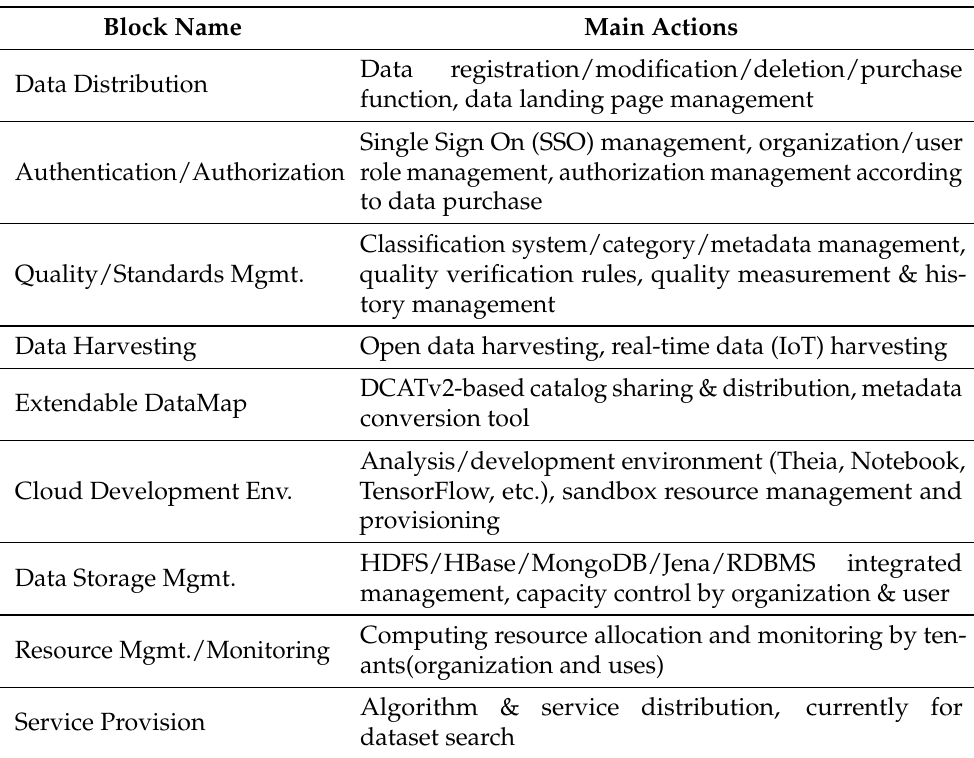
Figure 4. The overall framework of SODAS. Table 3. SODAS function blocks and main